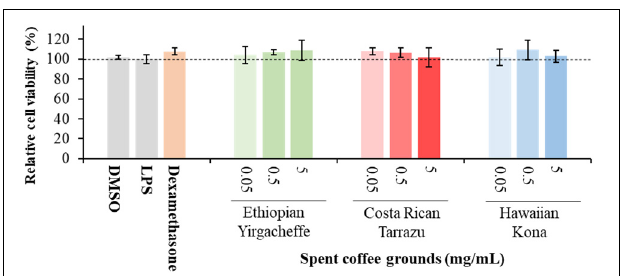
FIGURE 1 | Effect of DMSO, lipopolysaccharide (LPS), Dexamethasone, and spent coffee ground extracts on the viability of PMA-differentiated U-937 cells. DMSO, PMA-differentiated cells treated with 0.1% DMSO, no LPS, no coffee extracts; LPS, LPS and DMSO; coffee extracts, coffee extracts, DMSO